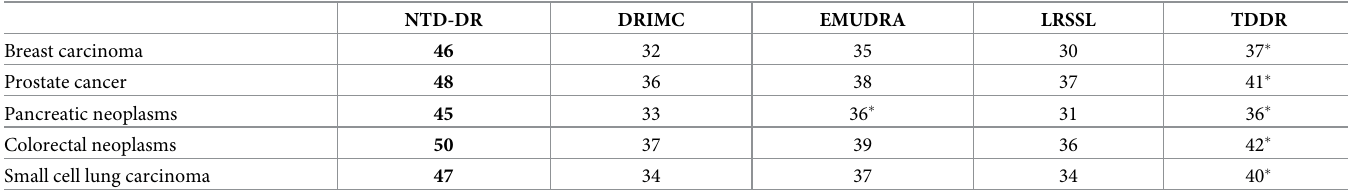
Table 1. The number of known associations in the top 50 predictions made by different methods for different diseases.